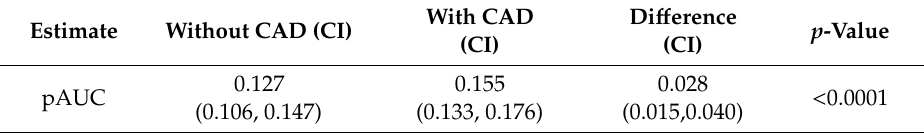
Table 8. The average specificity at a sensitivity = 0.95 for all readers. Average Without CAD (CI)